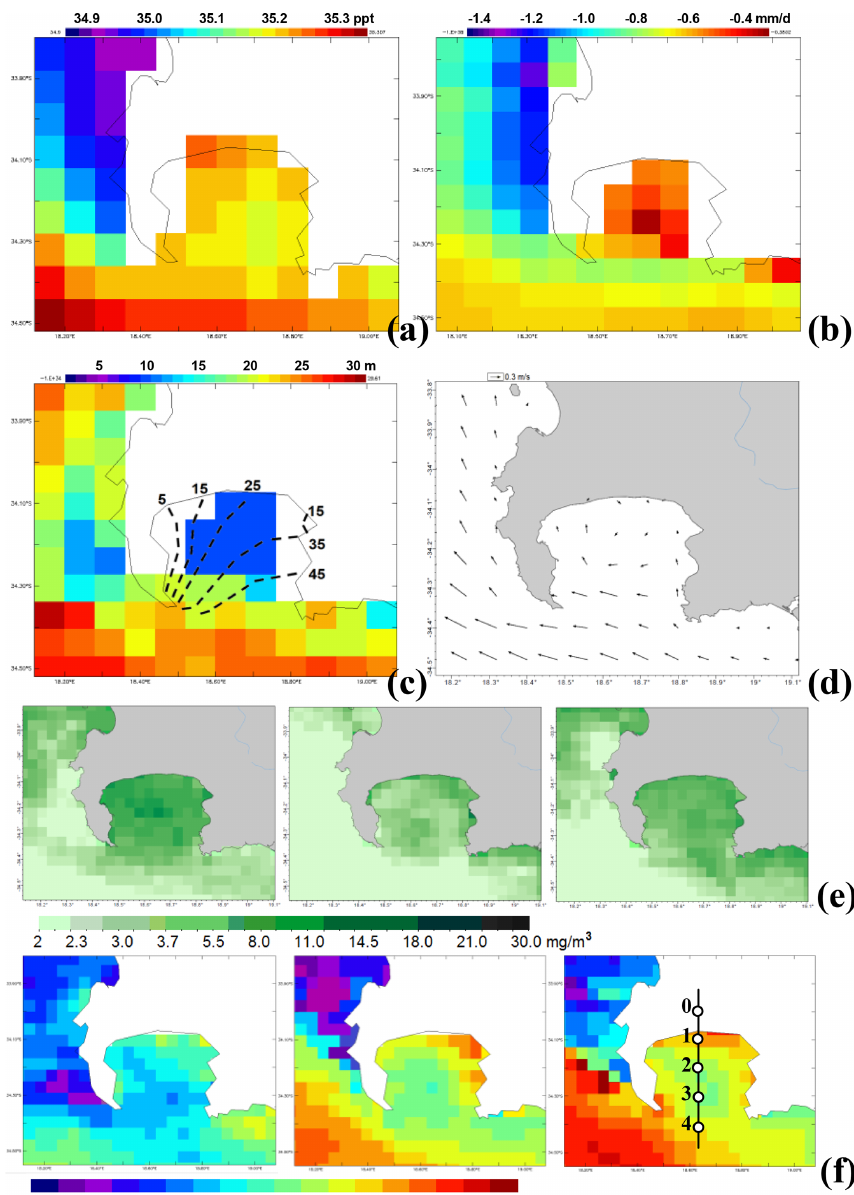
Figure 3. Mean ocean conditions for summer December 2012–February 2013 from HYCOM hindcast: (a) 2m salinity, (b) precipitation – evaporation balance, (c) mixed layer depth (m), and wave energy isolines (kWm − 1 , after Joubert and van Niekerk 2013) and (d) 6m currents, with raster shading at native resolution. Sequences of December 2012 (left) to February 2013 monthly 4km satellite: (e) VIIRS ocean colour (derived chlorophyll) and (f) MODIS sea surface temperature (C). Points in (f) indicate virtual stations for time series, Table 2 statistics and the depth section in Fig.